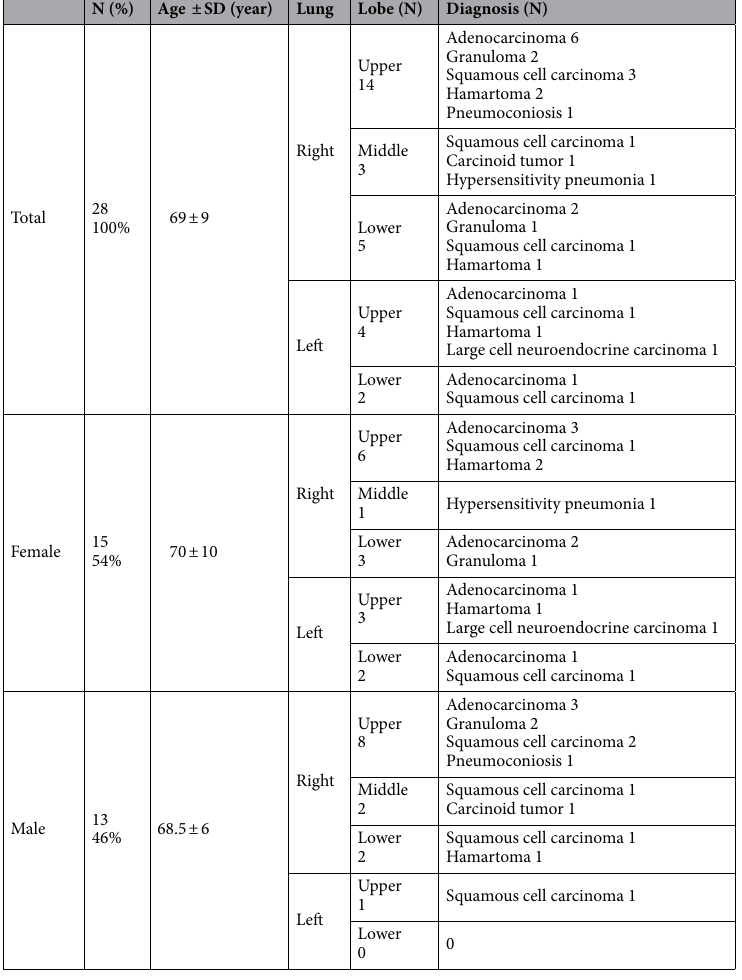
Table 2. Characteristics of the patients, localization, and the number solid lung nodules. N number, y years, SD standard